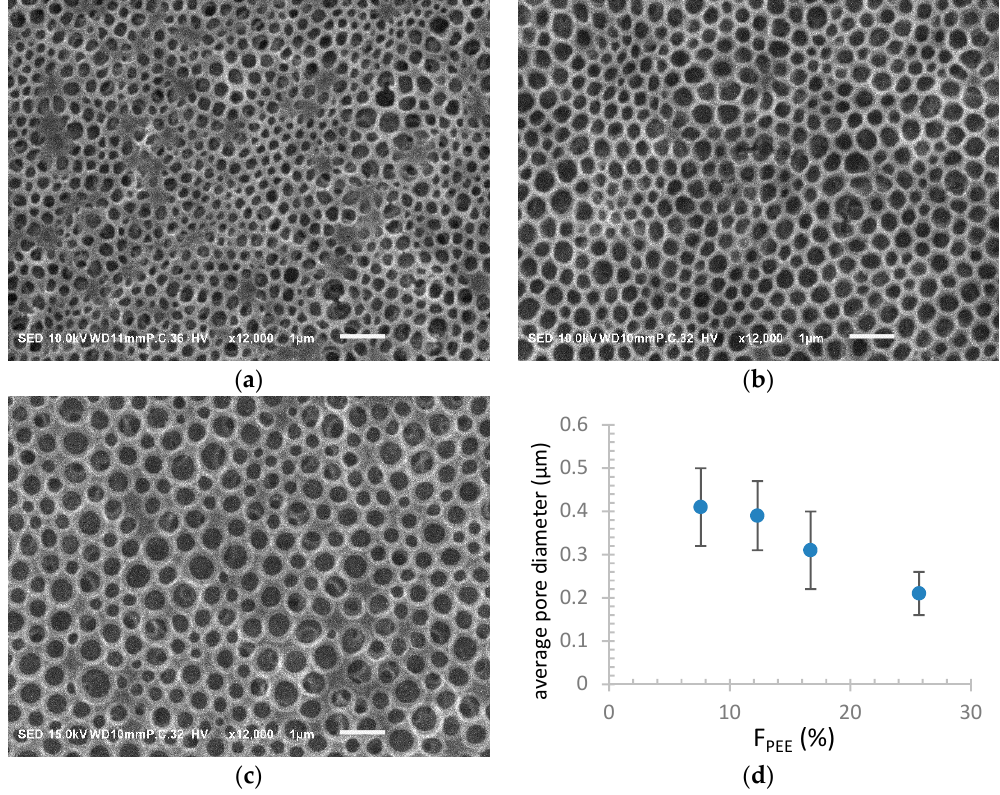
Figure 6. SEM images of BF films of third-generation LDBCs with hydroxyl end groups from THF/CHCl 3 solutions (1:3 v / v ): ( a ) deLG3-PSt 20k; ( b ) deLG3-PSt 30k; ( c ) deLG3-PSt 68k. ( d ) Plot of average pore size vs. F PEE .